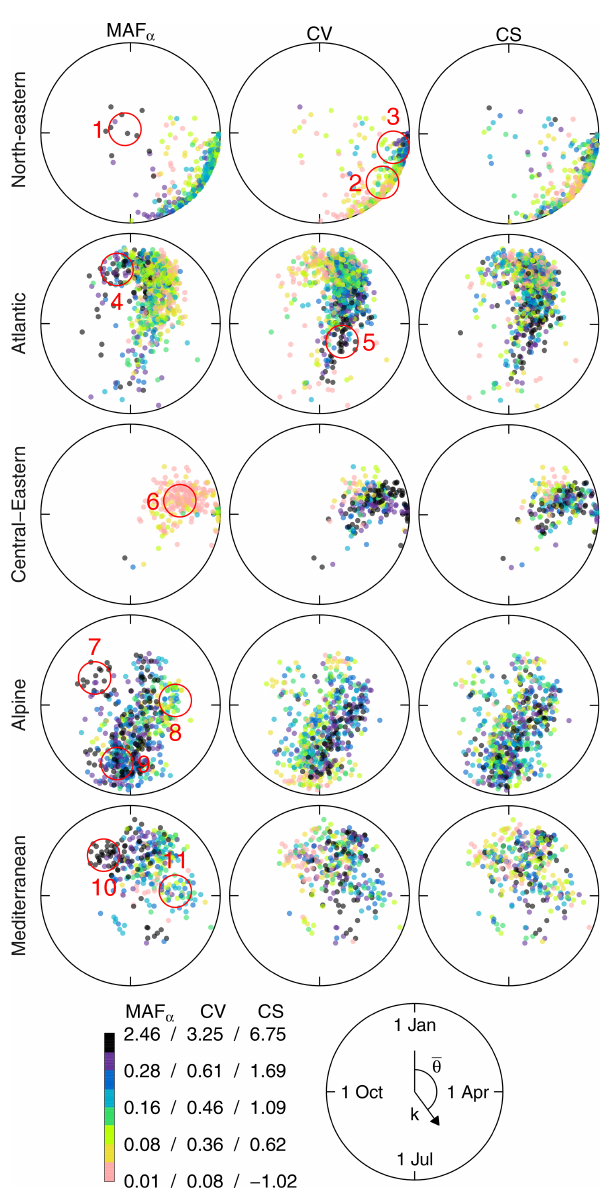
Figure 3. Seasonality of annual flood peaks. The position in the circle indicates the mean date of occurrence (angle) and variabil- ity of date (inverse of distance from the centre). Each point rep- resents one catchment. Colours of the points indicate flood mo- ments as in Fig. 2. Small red circles highlight subregions referred to in the text (1: Norwegian coast, 2: north-western Russia, 3: west- ern Russia, 4: western UK and south-western Norway, 5: southern Germany and north of the Czech Republic, 6: parts of Poland and Ukraine, 7: southern Austria and northern Slovenia, 8: Alpine and the Carpathian midlands, 9: Alpine region, 10: Slovenia and south- ern France, and 11: the